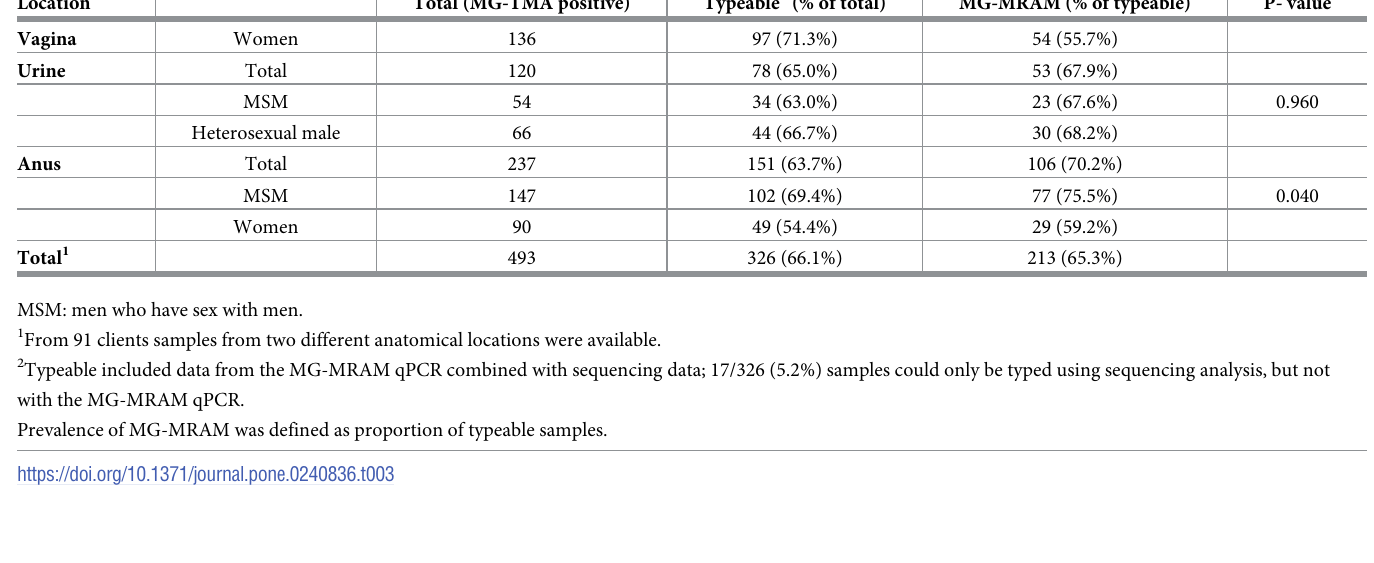
Table 3. Prevalence of MG with Macrolide Resistance-Associated Mutations (MG-MRAM) in samples derived from different anatomical locations typed by MG-MRAM qPCR and/or by sequencing analysis.